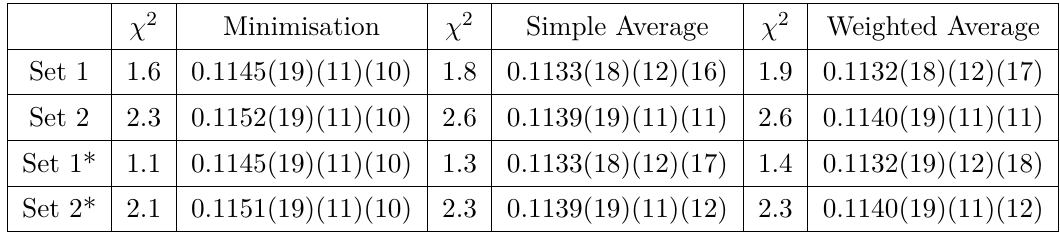
Table 8 . Averaged results for α ( n f =5) s ( M 2 variations and O 6 are assumed to be